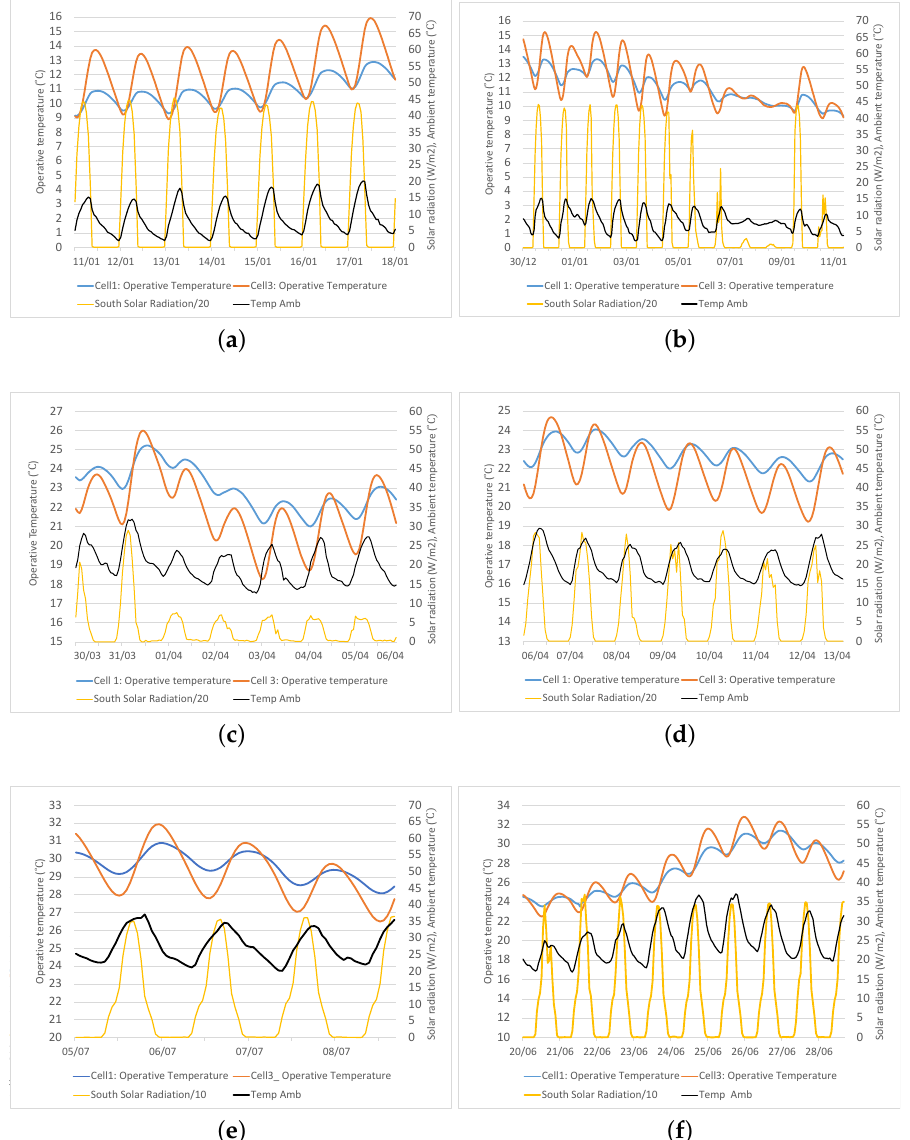
Figure 16. Comparison of the operative temperatures of Cell 1 (OVF) and Cell 3 (UVF). Wintertime: ( a ) grill open (11 January to 18 January 2021), ( b ) grill closed (29 December 2020 to 5 January 2021). Springtime: ( c ) grill open (30 March to 6 April 2021); ( d ) grill closed (6 to 13 April 2021). Summertime: ( e ) grill open (5 to 8 July 2021); ( f ) grill closed (20 to 28 June